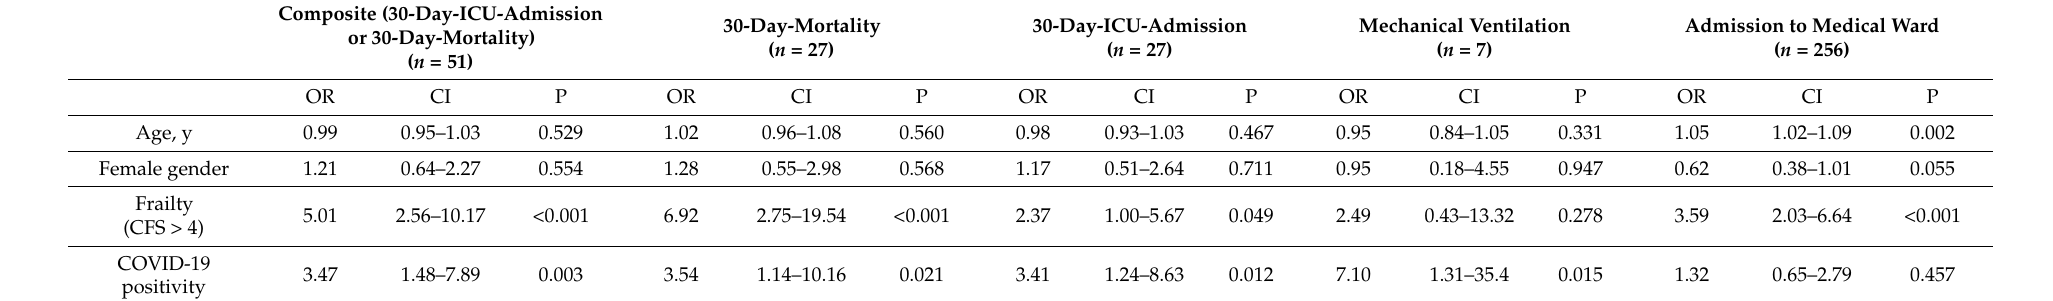
Table 2. Odds ratios for the respective